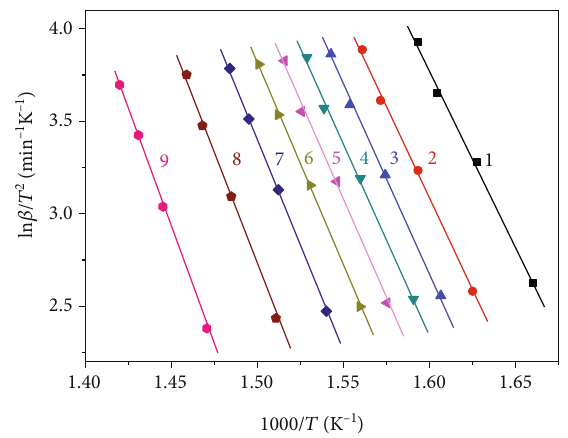
Figure 6: Representative KAS plot of pure NR with conversion ranging from 0.1 to